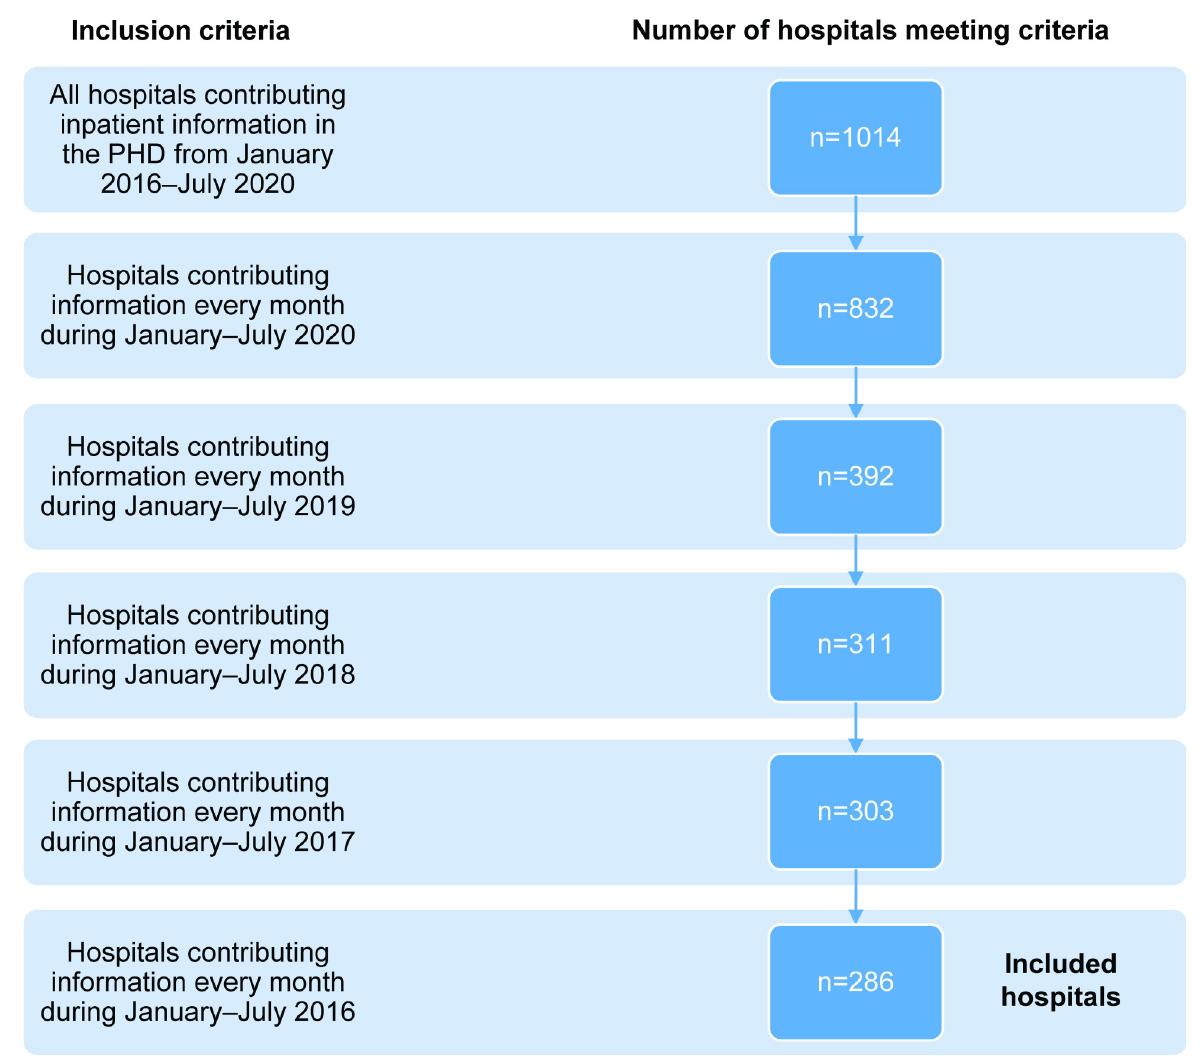
Fig 1. Hospital selection criteria. PHD = Premier Healthcare